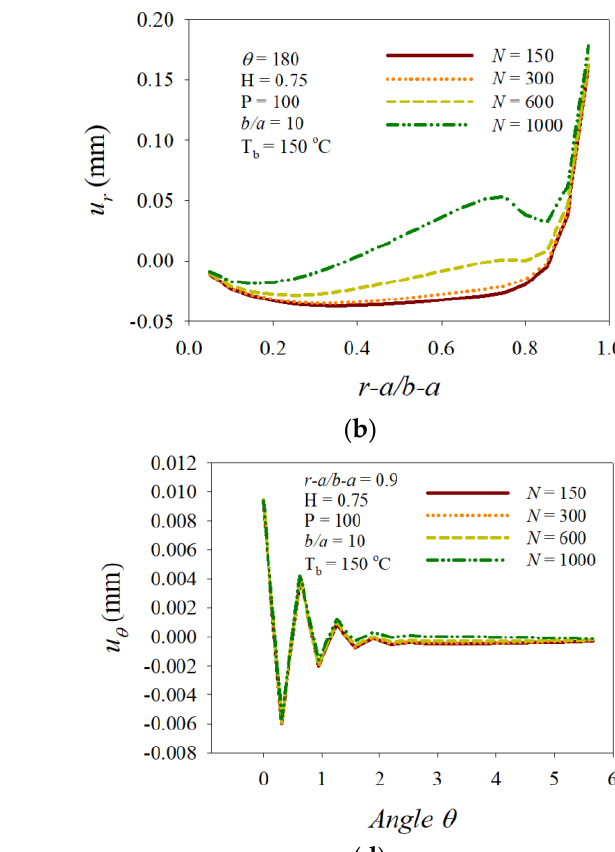
( d ) Figure 6. Effects of outer boundary temperature on the components of strain: ( a ) radial at θ = 0 , ( b ) radial at θ = 180 , ( c ) circumferential at ( r − a)/(b − a) = 0.1, ( d ) circumferential at (r − a)/(b − a) = 0.9. The influence of the angular velocity on the thermo-elastic characteristics are pre- sented in Figures 7 – 9. The values of the revolutions per minute N = 150, N = 300, N = 600, and N = 1000 were chosen as the representative angular velocities. Figure 7 exhibits the displacement distributions. As shown in Figure 7a, the effect of the angular velocity on the radial displacement was small at 𝜃 = 0 and a slightly larger radial displacement was produced with the growth in the angular velocity over the area of 0.2 < (r − a)/(b − a) < 0.9. However, the opposite side to the loading point reacted sensitively to the variation in